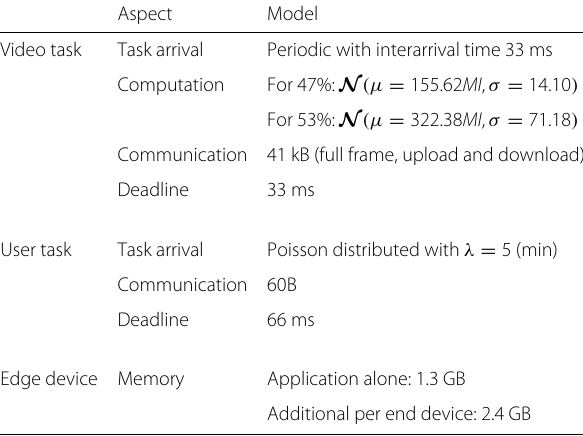
Table 3 Overview of the proposed MR workload model